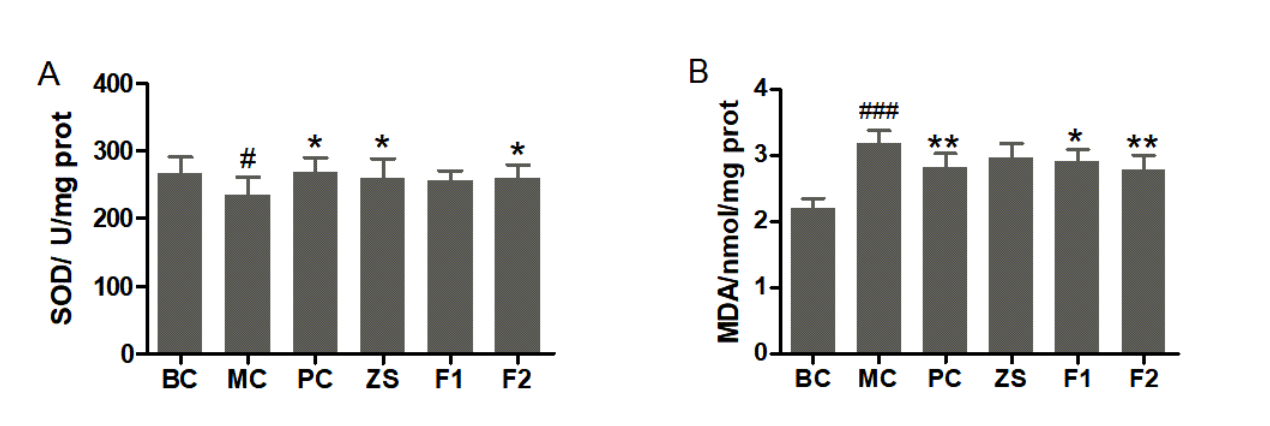
FIGURE 4 - Effect of BCLE on SOD (A) and MDA (B) in KK-A y mice (data are expressed as means ± SD)